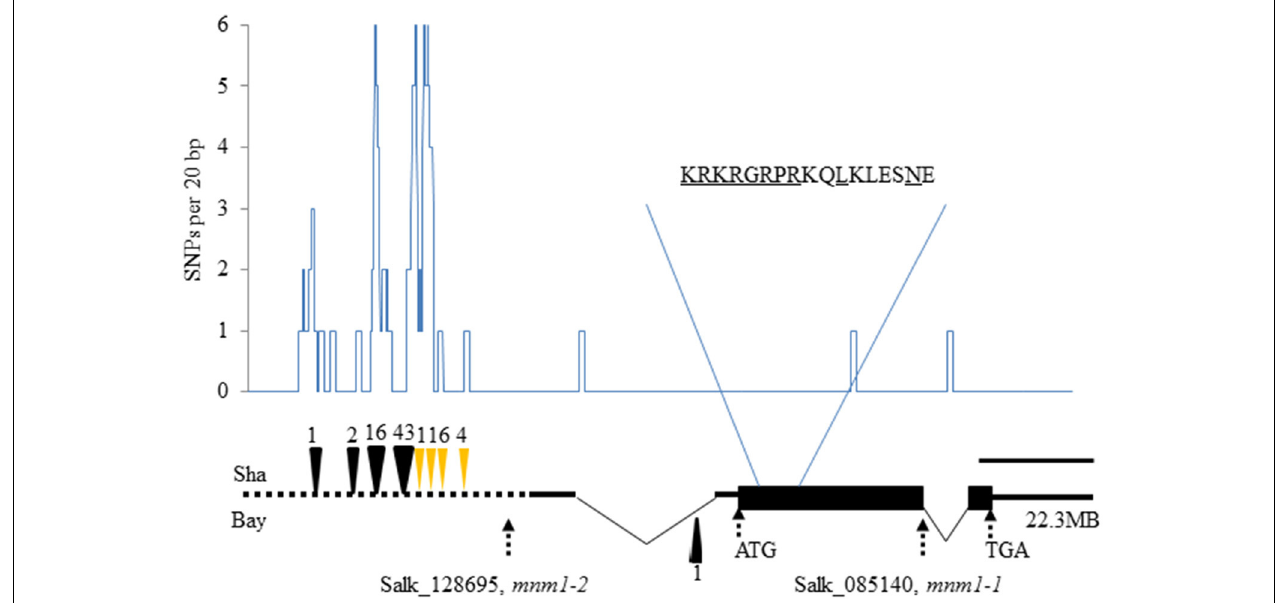
FIGURE 2 | Natural and induced variation in MNM1 . The gene structure of MNM1 is shown with the wide black rectangle showing the open reading frame. The 5 (cid:3) and 3 (cid:3) untranslated regions are shown as solid black lines with introns shown by the thin triangle. The promoter analyzed is shown by the dotted black line. The graph shows the number of single nucleotide polymorphisms per 20 basepairs between the Bay and Sha genomic sequences. The deletions with respect to the Col-0 sequence are shown as